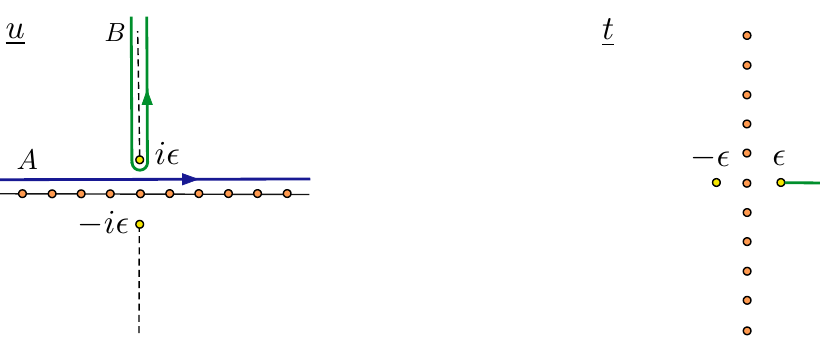
Figure 9 . Integration contours for Z PI . Orange dots are poles, yellow dots branch